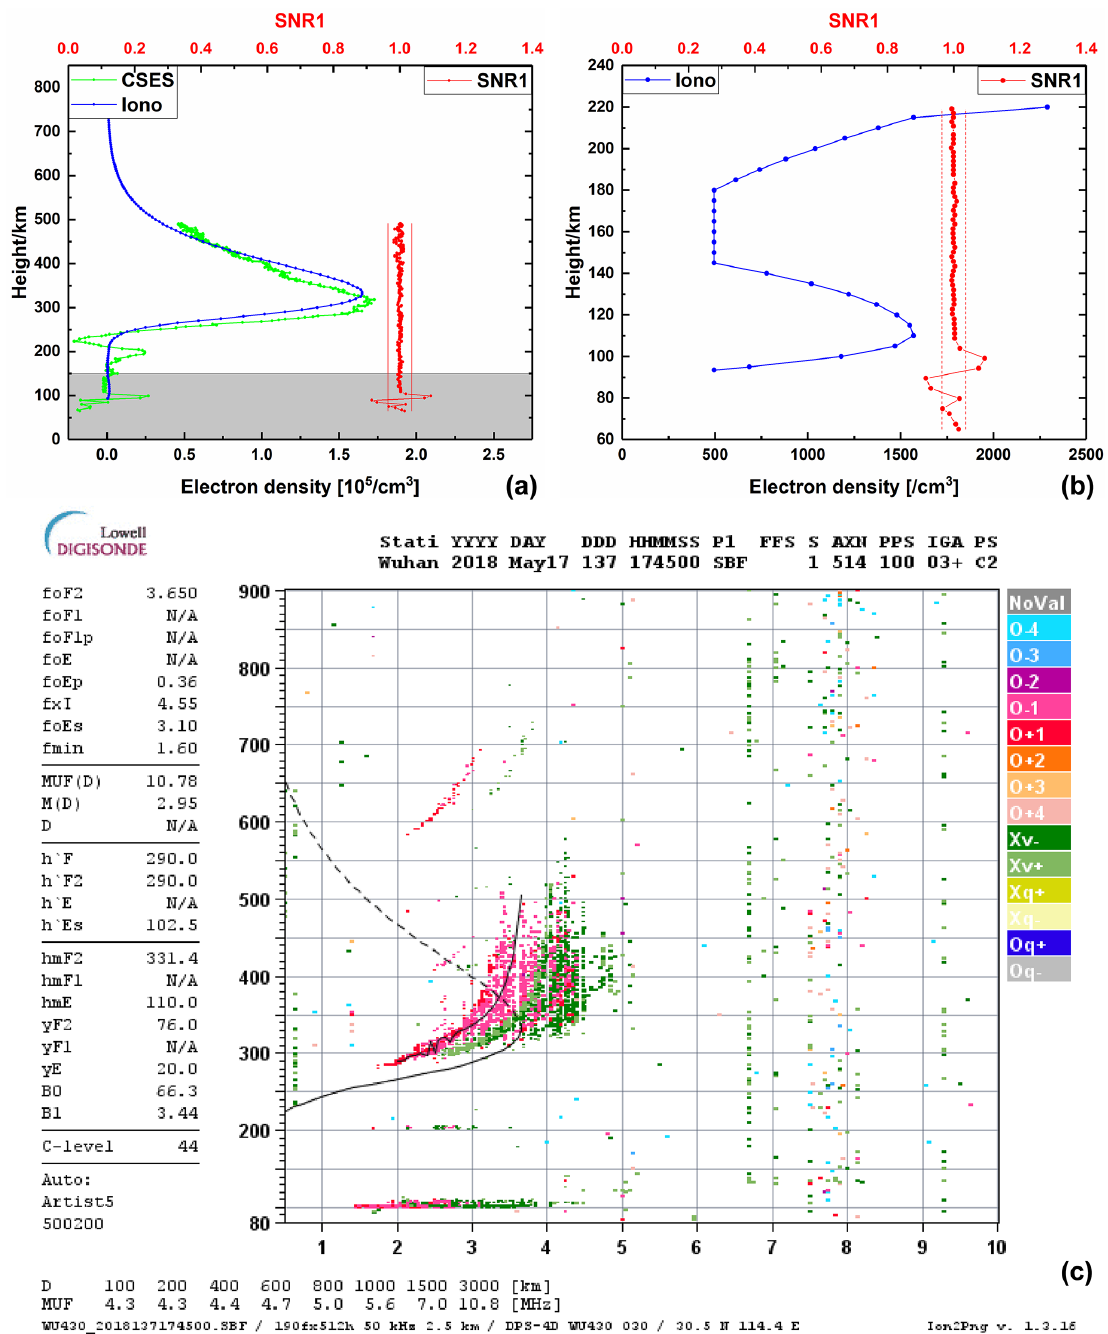
Figure 7. An example of simultaneous detecting of E s by CSES and ZLT ionosonde. Panel (a) shows the electron density profile and the SNR1 profile of G27 satellite at 17:42GPST on 17 May 2018, as well as the electron density profile of ZLT ionosonde at 17:45UTC on 17 May 2018. Panel (b) shows the electron density profile of ZLT ionosonde and the SNR1 profile in the range of 0–220km. Panel (c) shows the ionogram image of Wuhan ZLT